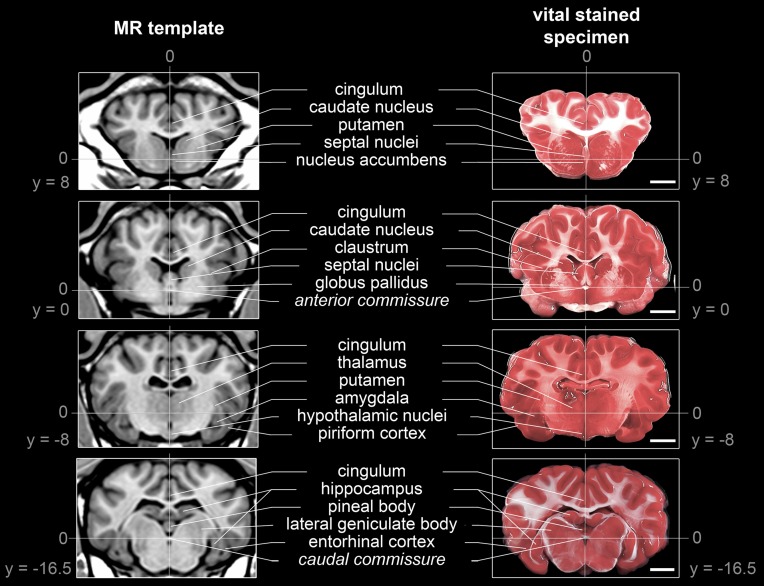
Comparison of subcortical structure detectability in the population-averaged T1w template and a TTC-stained brain slice. Structures were selected according to neuro-anatomical reference paper (Cooley and Vanderwolf, 2004; Schmidt et al., 2012): The anterior commissure (AC) as origin of the stereotaxic space [0;0;0] and the posterior commissure (PC) could be identified in both modalities. Note that the coronal planes of the stained slices were not perfectly parallel to the z-axis due to minimal deviations during the slicing procedure. All coordinates are given in mm. Scale bars: 10 mm.